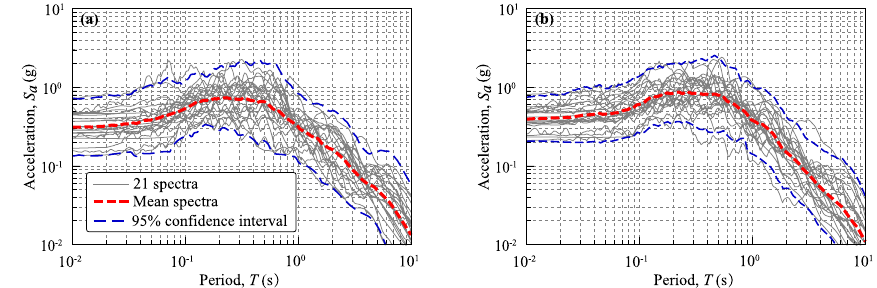
Fig. 3 Acceleration response spectra of the selected earthquake records: a ground motion components along the X-axis and b ground motion components along the Y-axis